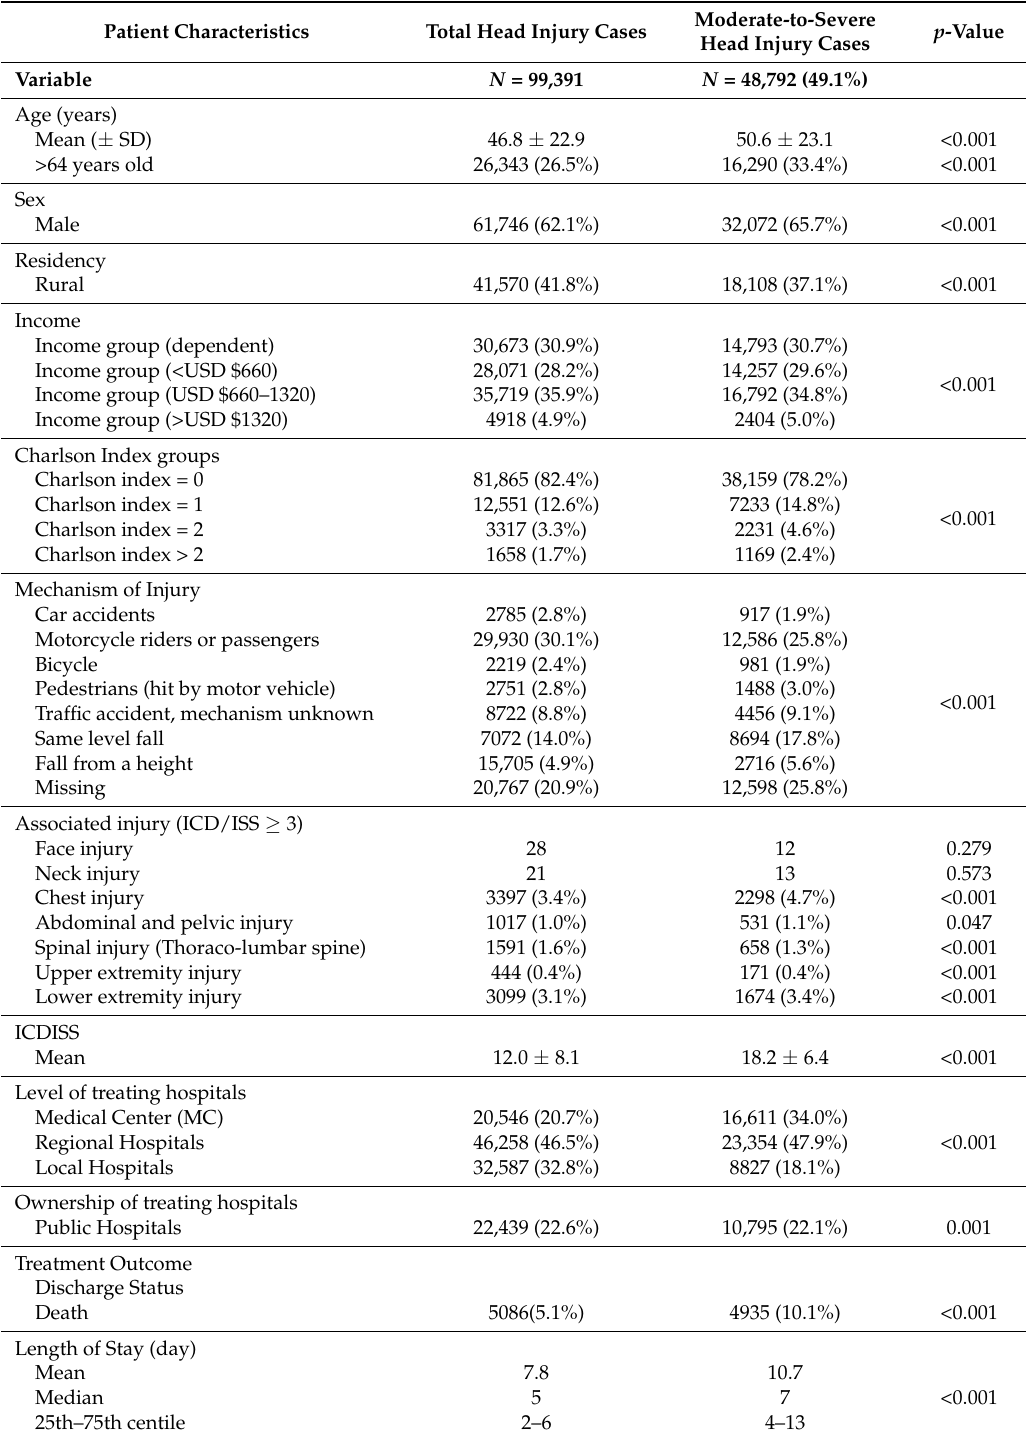
Table 4. Patients demographics in mild and moderate-to-severe head injury